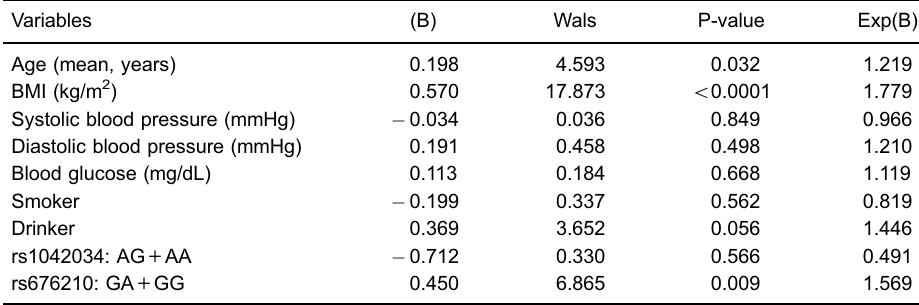
Table 5. Multivariate regression results of hyperlipidemia pathogenic